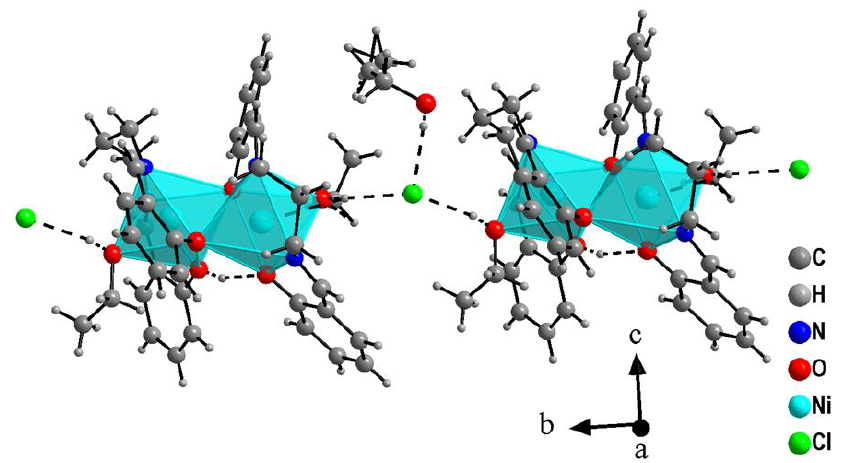
Figure 3. The Ni 2 N 4 O 6 dimers linked by hydrogen bonds through solvent